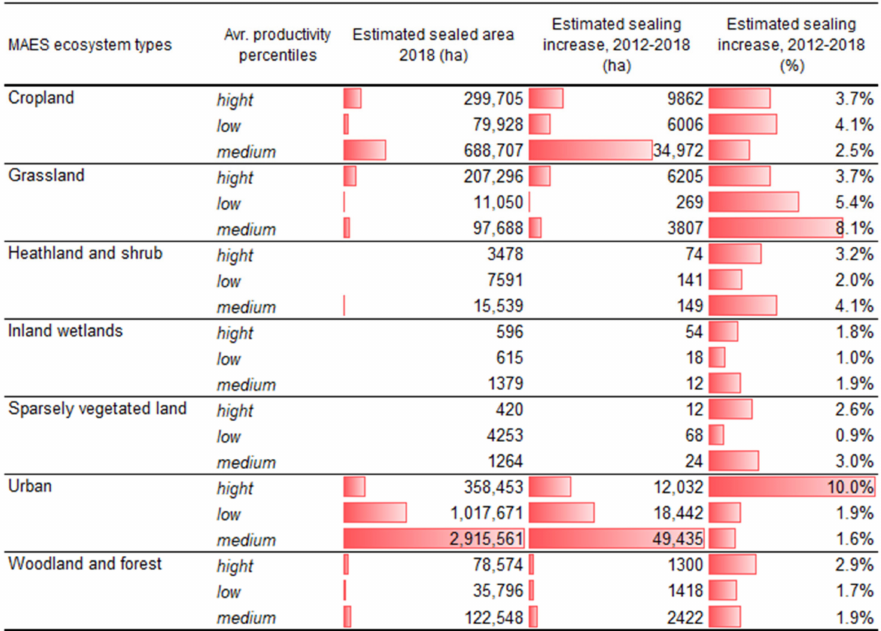
Figure 3. Soil sealing and sealing increased during 2012–2018 in FUAs by ecosystem types and land productivity classes (h = high, m = medium, l = low) in the EU-27 and the